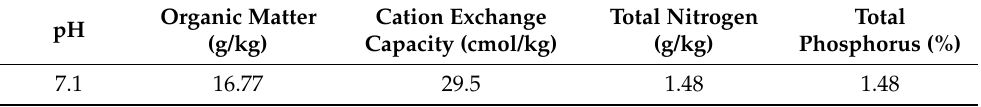
Table 1. Basic properties of the tested